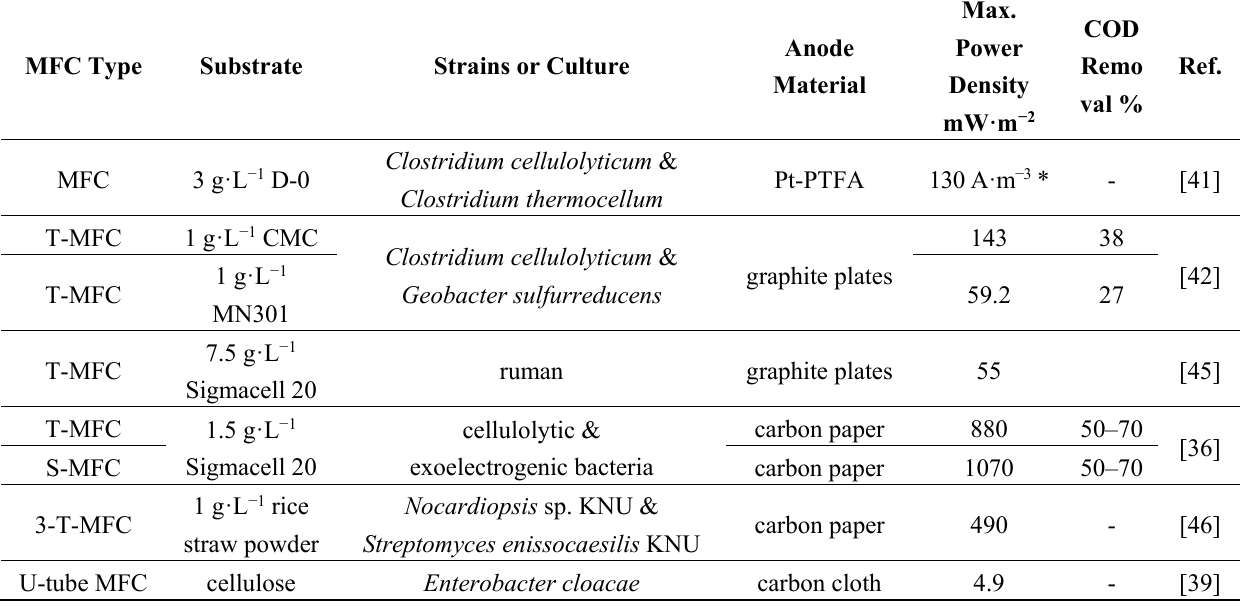
Table 2. Performance comparison of MFCs for treating cellulose